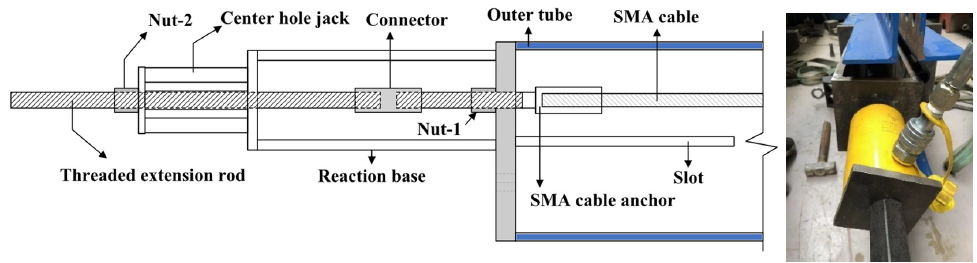
Figure 10. Pre-tension equipment.